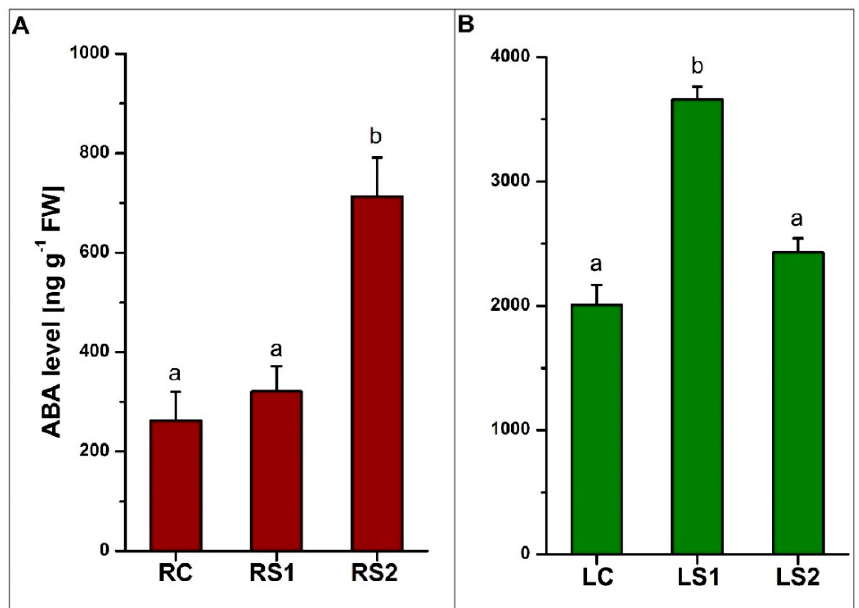
Figure 5. Quantitative analysis of abscisic acid (ABA) levels in fine absorptive roots ( A ) and leaves ( B ) during senescence. Means designated by different letters indicate statistically significant differences according to ANOVA and Tukey’s post hoc test ( p < 0.05). Values represent the mean ± SE (standard error).